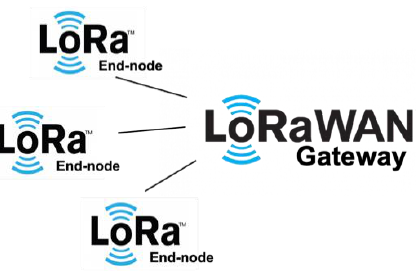
Figure 3. Standard LoRaWAN Elements.